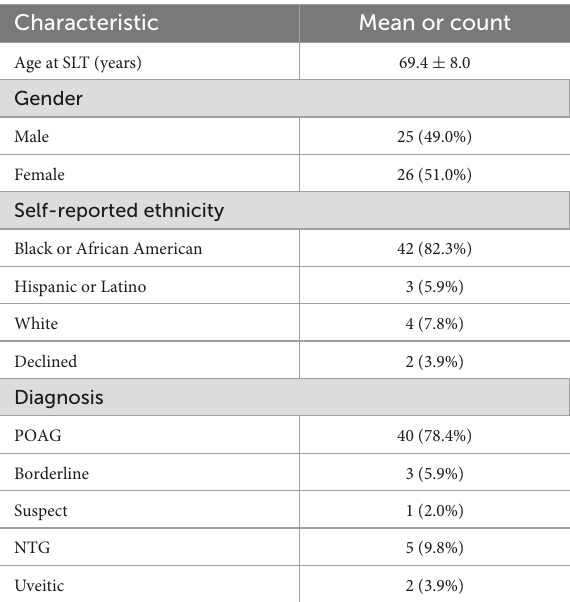
TABLE 1 Baseline demographic and clinical characteristics of